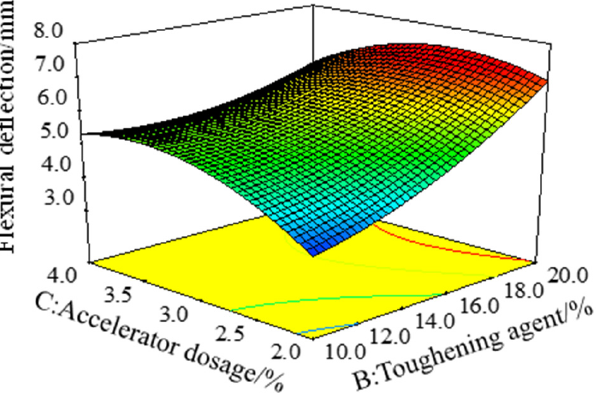
Figure 6. Response surface of bending strength (